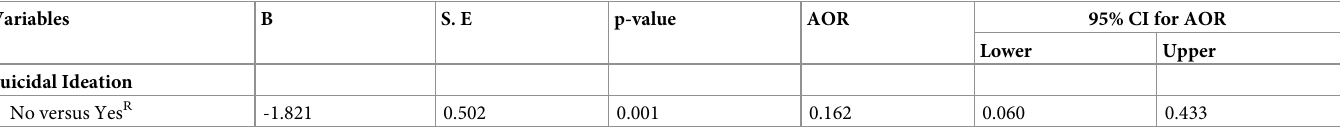
N. B.: B-Coefficient; S. E. -Standard Error; AOR -Adjusted Odds Ratio; CI -Confidence Interval; R